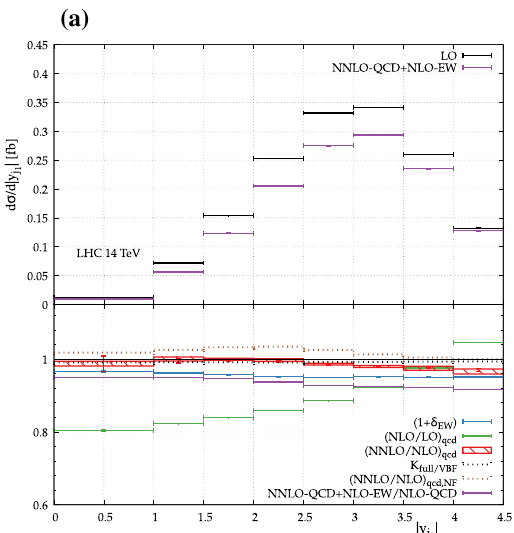
absolute contributions at NNLO QCD + NLO EW and the LO predic- tion. The lower panel shows the relative corrections. The bands denote the envelope of the QCD scale